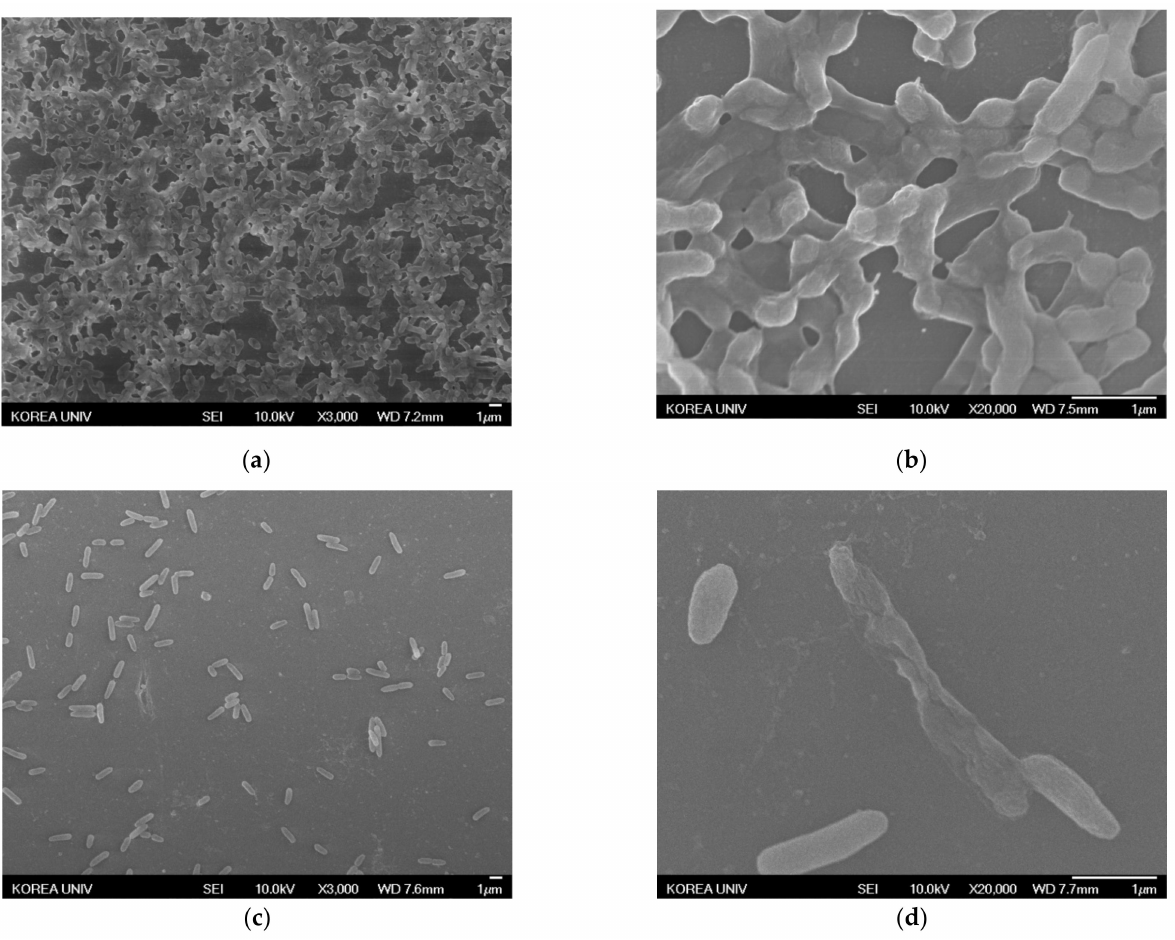
Figure 9. SEM images of MRPA treated with AgNPs. ( a ) Negative control magnified 3000 × . ( b ) Negative control magnified 20,000 × . ( c ) AgNP-treated MRPA magnified 3000 × . ( d ) AgNP-treated MRPA magnified 20,000 × .